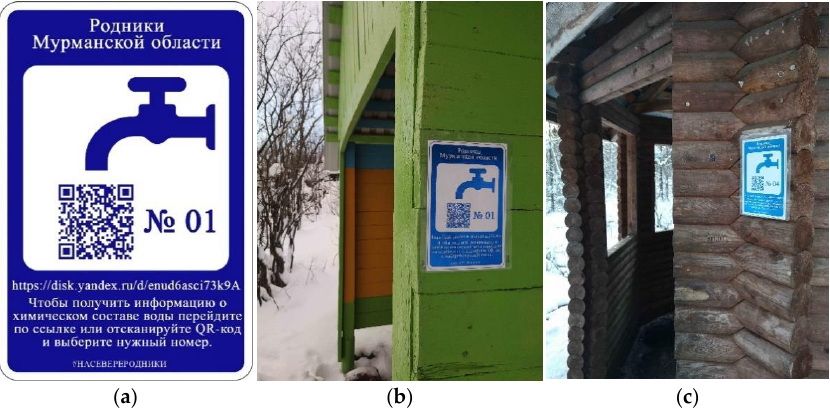
Figure 4. Plates with the link to information on the chemical composition of the spring water: ( a ) an example of a plate (in Russian) with a QR code; ( b , c ) examples of plate placement.